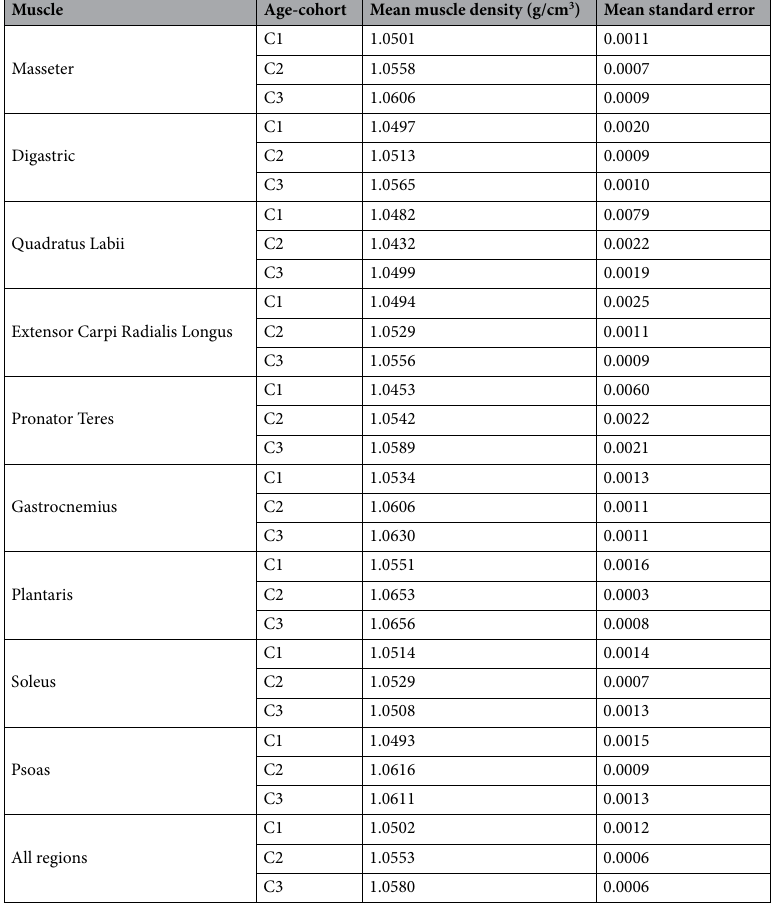
Table 2. The mean muscle density, mean standard error and results within each age-cohort (C1 = 3 weeks old; C2 = 8 months old; C3 = 2 years old).